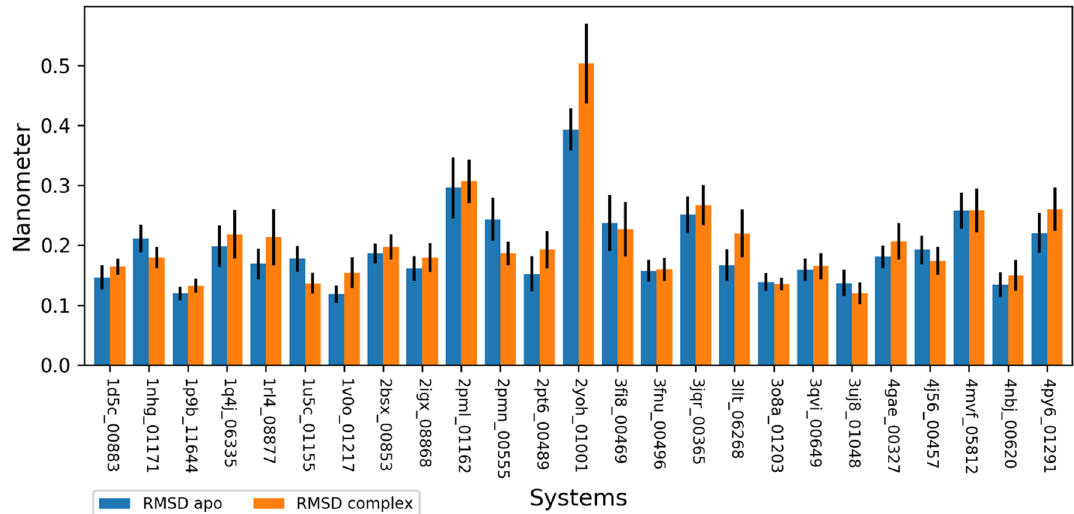
Figure 5. Mean of RMSD of backbone atoms after a least-squares fit to the initial structure for apo proteins and complexes during the 20 ns simulation. Protein–Ligand systems are represented by their PDB IDs and DrugBank IDs (last five digits). Error bars represent the standard deviation of the means (σ). Color code: orange: complexes; blue: apo